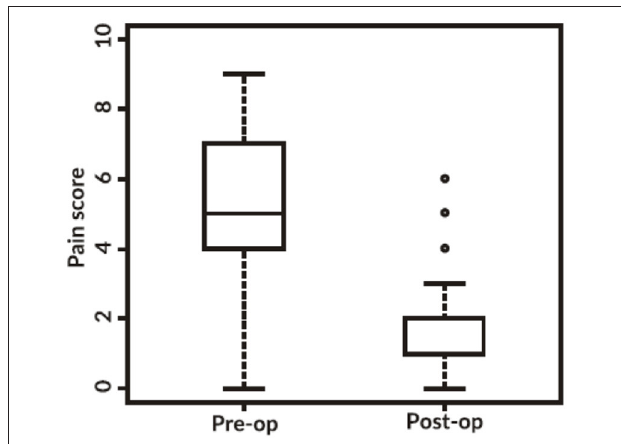
FIGURE 1 | Box plot demonstrating the pre-op and post-op pain scores reported ( p <